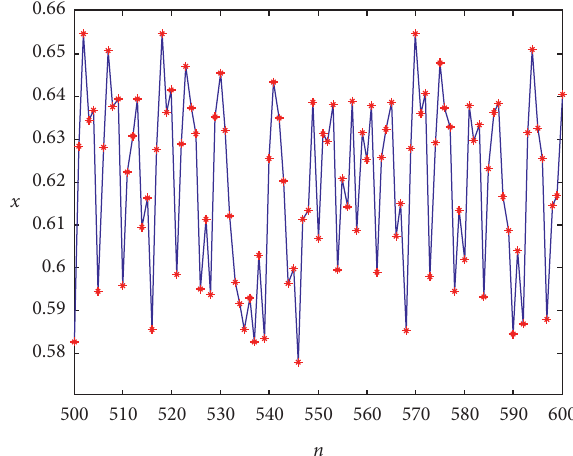
Figure 11: Flip bifurcation diagram versus parameters β when a � 1, b � 1.14, c � 2.93, d � 1.3, e � 0.21, f � 0.1, g � 0.35, h � 2, α � 0.05, c � 0.5.